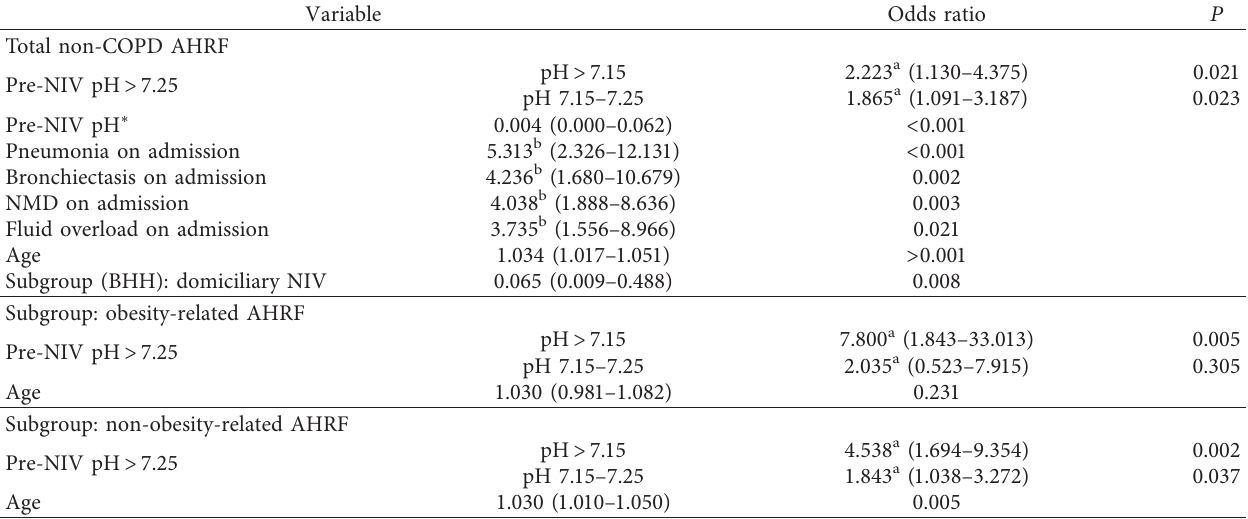
Table 3: Multivariable logistic regression demonstrating the predictors of in-hospital mortality.